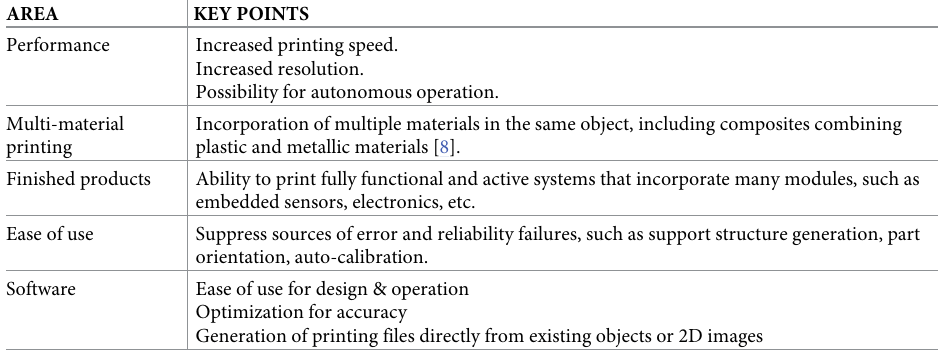
Table 1. Key points to improve in current state-of-art 3D printing